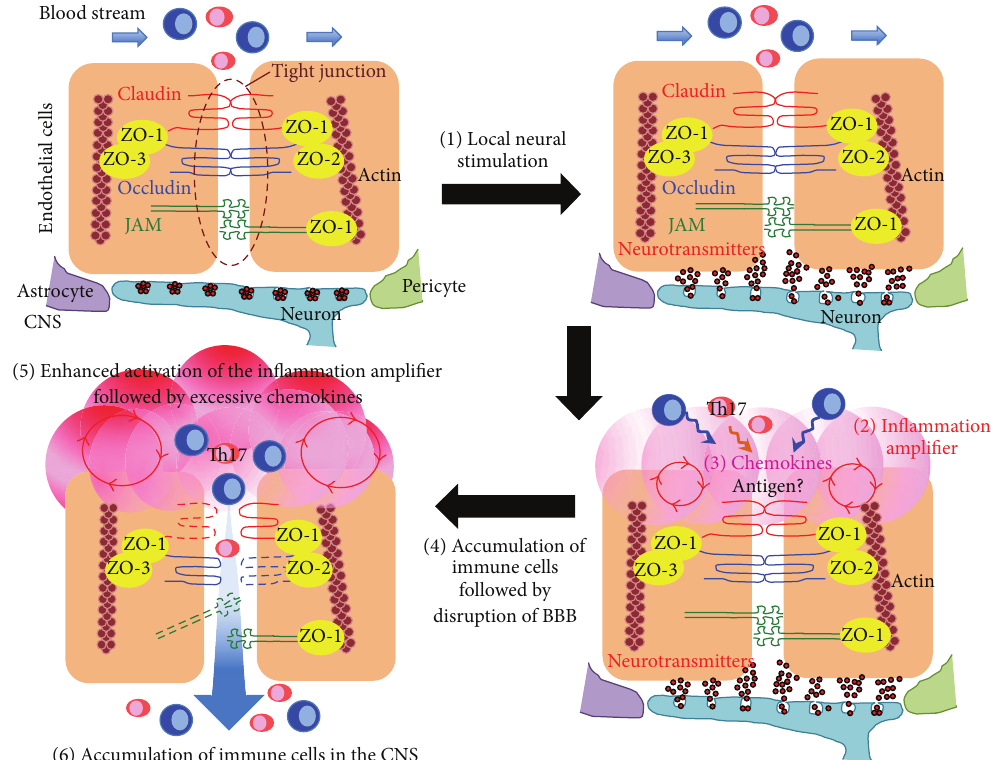
Figure 7: Schematic representation of the gate theory in the CNS. The gate theory describes how regional neural stimulations direct immune cell infiltration into target organs by crossing gates located at various blood vessels. Immune cells in the blood stream cannot enter the target organs due to homeostasis of the venules (upper left). Regional neural stimulation secretes neurotransmitters including norepinephrine into the endothelial cells of the venules (upper right). This stimulation activates the inflammation amplifier in the endothelial cells followed by increasing local chemokine expression (bottom right). The accumulation of immune cells disrupts the BBB, which allows immune cells to enter the CNS (bottom